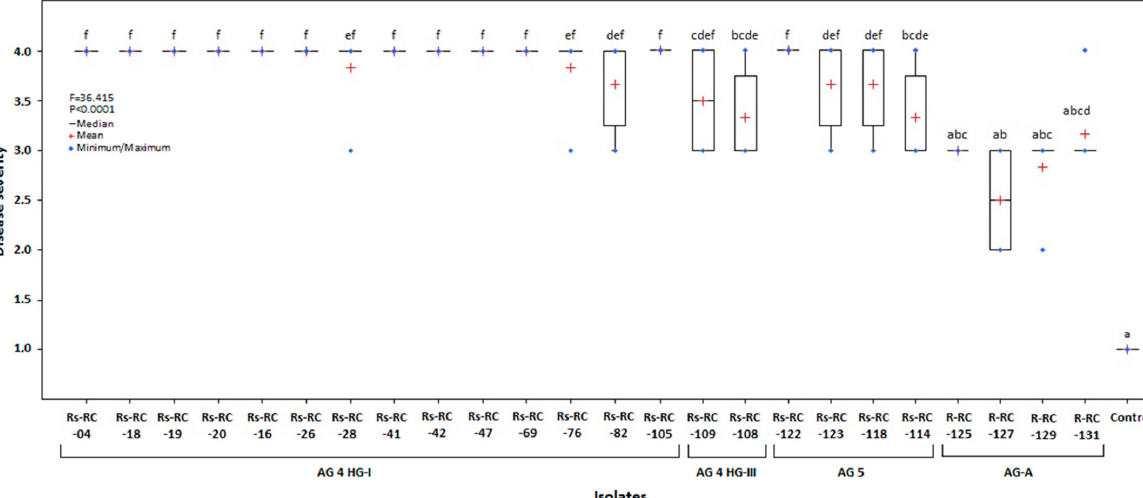
Figure 6. Pathogenicity of Rhizoctonia spp. isolates obtained from red cabbage to seedlings of the cv. Rondale twenty-one days after inoculation. Seedling/root symptoms were evaluated 21 days after inoculation based on the following scale: 1 = no symptom; 4 = basal rot deeply girdled stem, stem base was constricted, roots were sometimes detached from stem, and plants wilted. Values followed by the same letter are not significantly different according to Dunn-test based on the rank sums using the Kruskal–Wallis ( p < 0.0001).